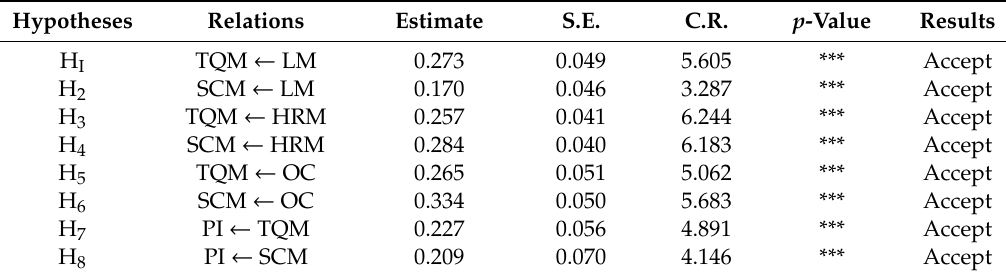
Table 5. Structural model